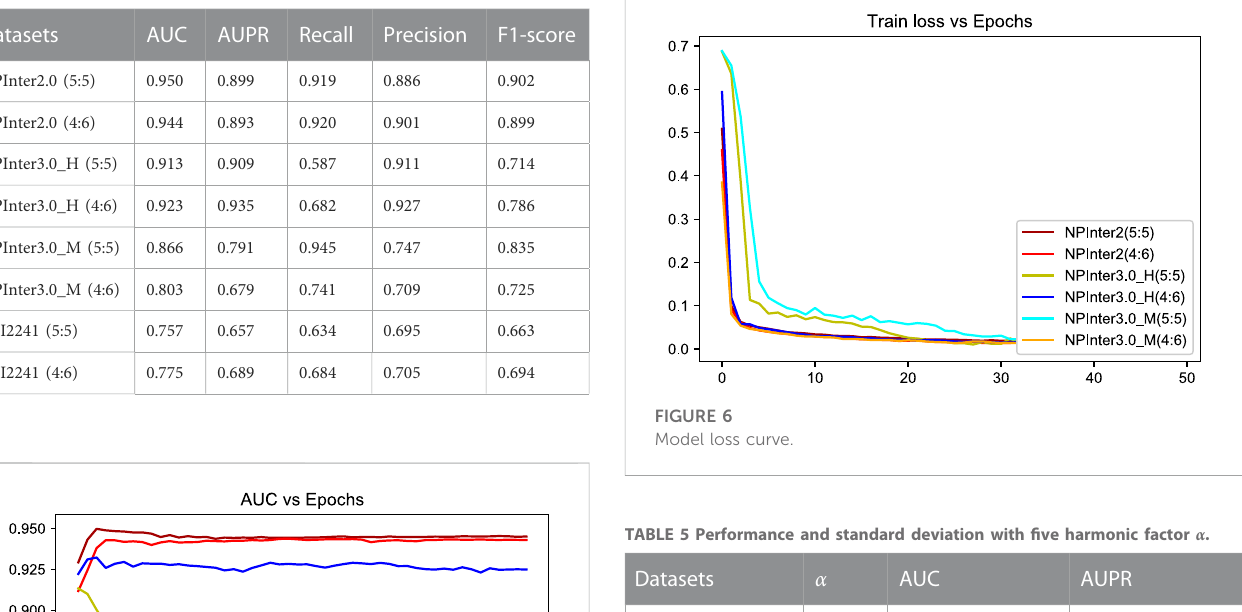
TABLE 4 Performance of BiHo-GNN on four different datasets.